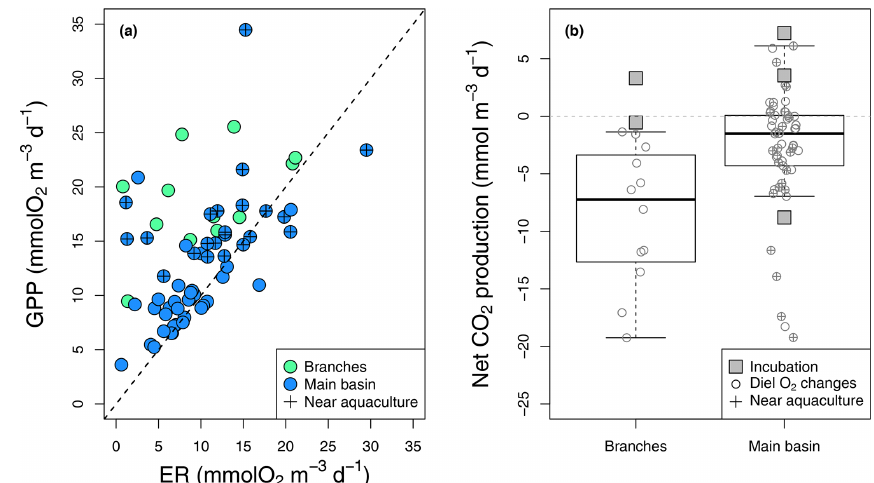
Figure 4. Epilimnetic daily GPP vs. ER rates (a) derived from diel O 2 changes in the reservoir branches and main basin (including sites near aquacultures), with the 1 : 1 line (dotted). (b) Boxplots of the corresponding rates of CO 2 NEP in the branches and main basin, with box bounds, whiskers, solid line, open circles, and squares representing the 25th and 75th percentiles, the 10th and 90th percentiles, the median, single data points (diel O 2 method), and incubation-derived rates respectively.